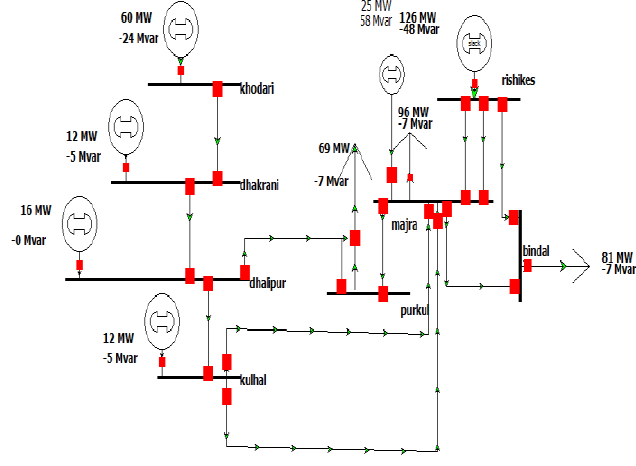
Fig.14 Dehradun system with one RES of 25MW at Majra bus TABLE. 10 Ei OF THE SYSTEM WITH ONE RES From Bus